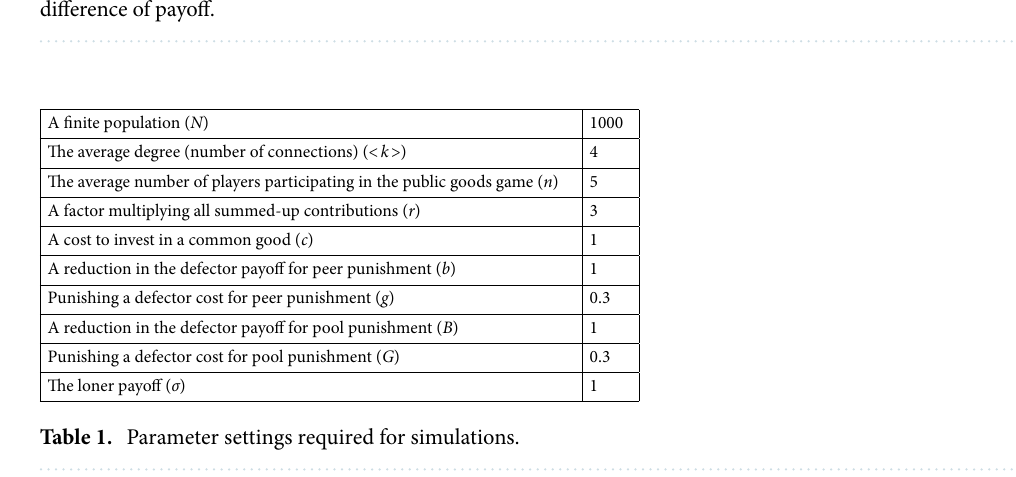
Figure 2. This figure illustrates the characteristics of the probabilistic pool punishment proportional to the difference of payoff.